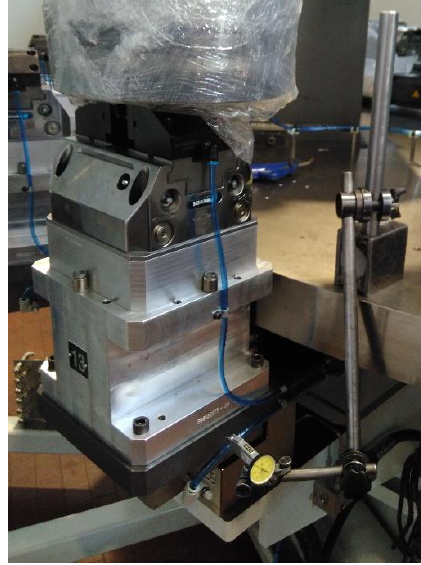
Figure 20. Experimental measurement of the vertical displacement of the support in the case of Fy (−) = 500 N.